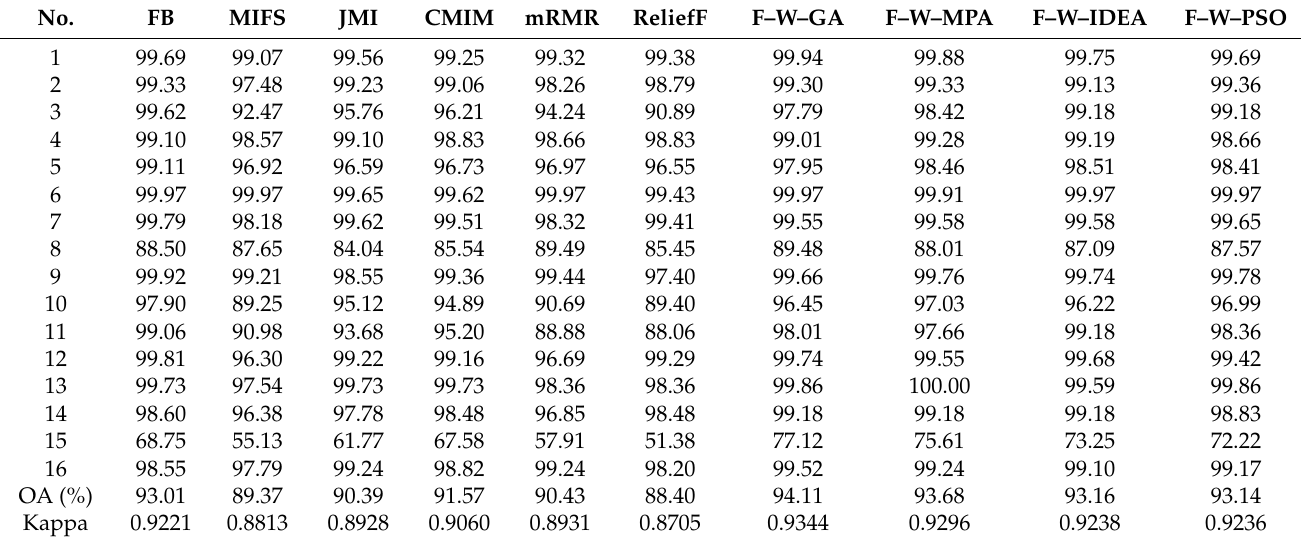
Table 7. The OA, Kappa coefficient, and accuracy of each class for Salinas